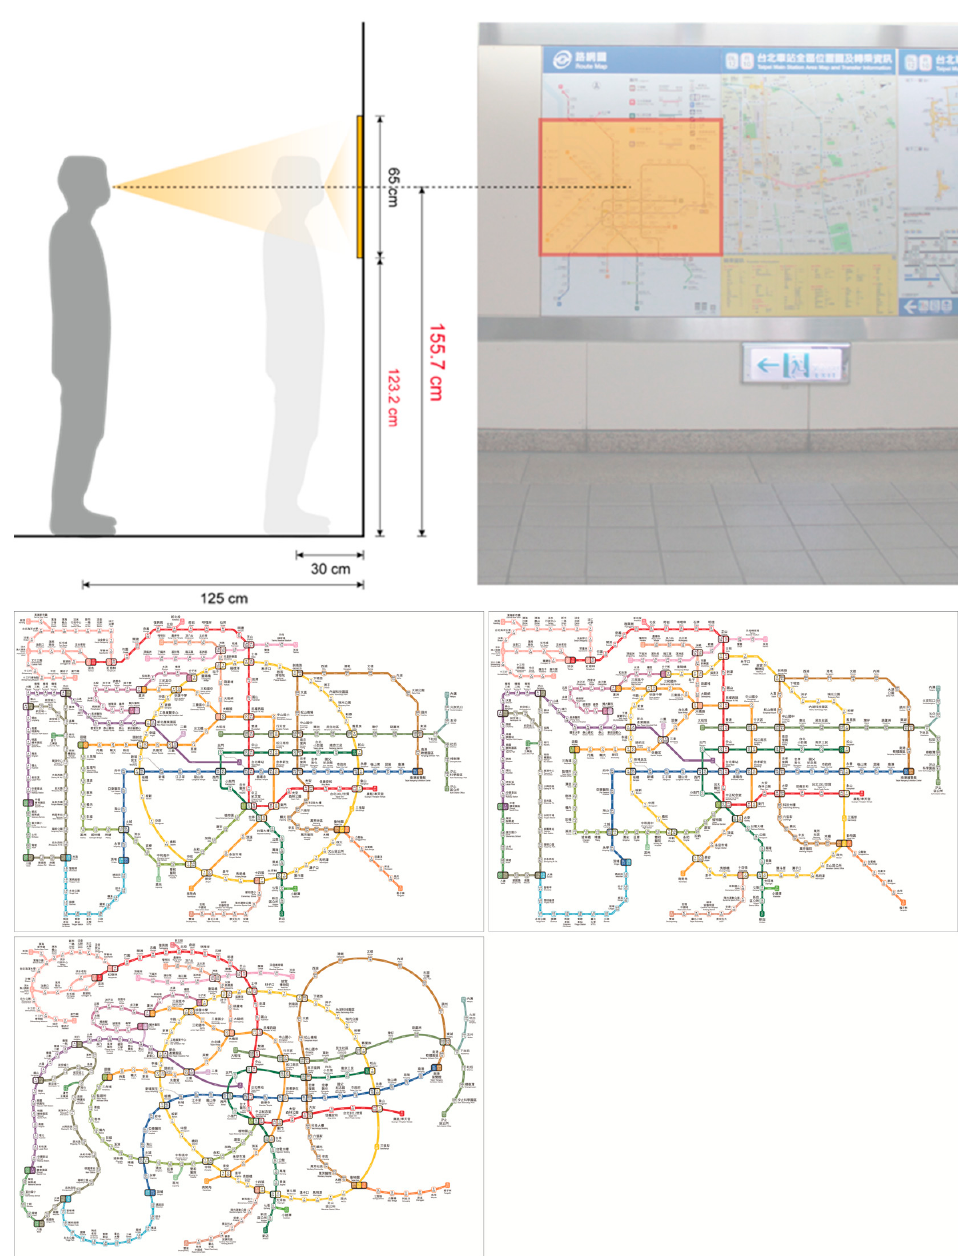
Figure 3. New route maps design.